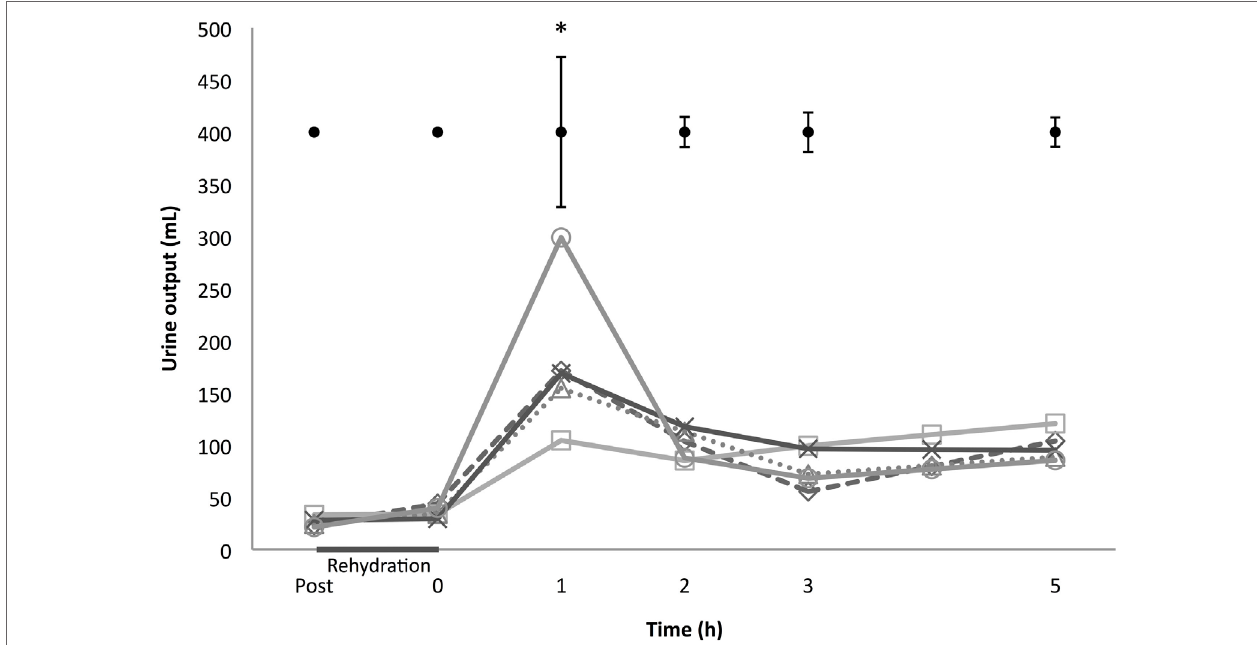
FigUre 1 | Urine output . Starting post-exercise and ending 5 h after rehydration: Δ 0% beer; × 2% beer; ○ 5% beer; □ sports drink; ◊ water. At the top are ± 1 pooled SD bars per time point. * p < 0.01 between 5% beer and sports drink, 1 h in the post-rehydration